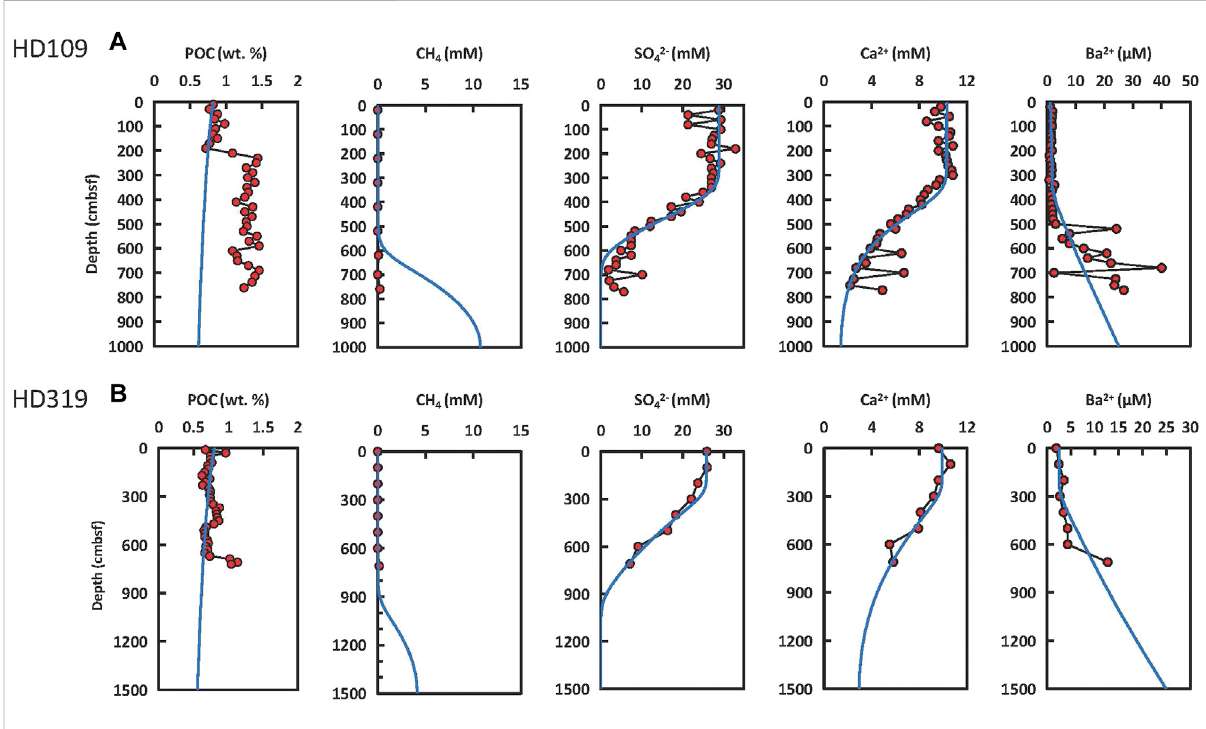
FIGURE 4 Measureddata (dots)andsimulatedresults fromthesteady-state model(curves)ofcoresHD109 (A) andHD319 (B) .Downwardconcentrations of POC, CH4, SO42 − , Ca2+ and Ba2+ are shown.